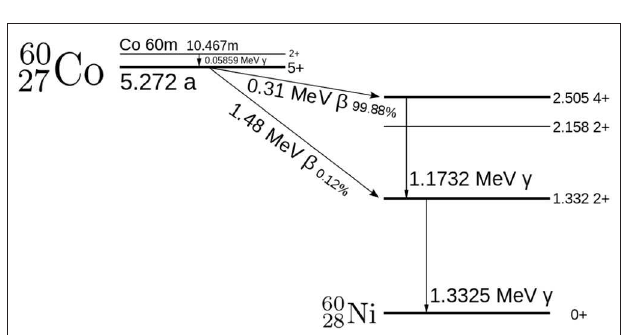
FIGURE 3 | Beta decay of 60 27 Co is followed by emission of gamma at 1.17 and 1.33 MeV from 60 28 Ni ( Camp and Van Hise,